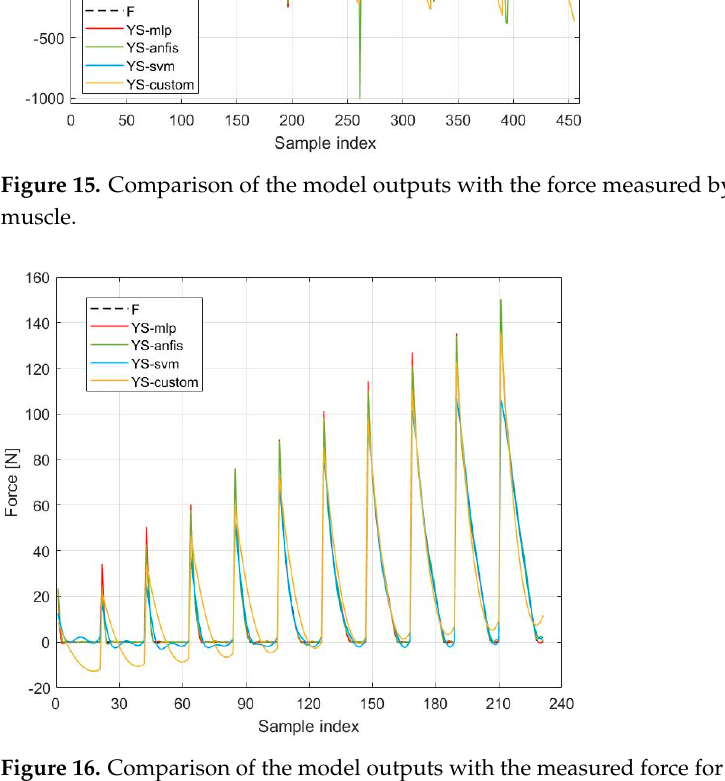
Figure 15. Comparison of the model outputs with the force measured by FESTO for the DMSP − 20 muscle. A comparison of the outputs of the best models in one graph, together with the ex- perimentally obtained data for the DMSP − 5 muscle, is shown in Figure 16. The measured tensile force is indicated by a black dashed line labeled F . The outputs of the individual models are shown by solid colored lines: